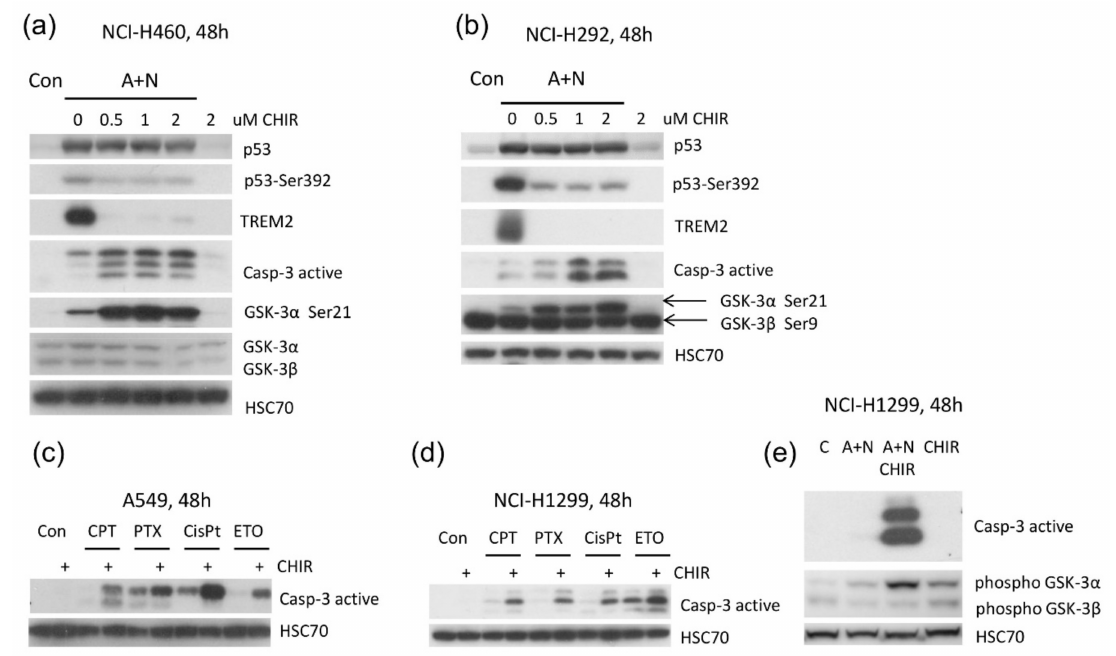
Figure 8. CHIR-98014 promotes activation of caspase-3 and represses TREM2 in cell lines other than A549. ( a , b ) Two lung cancer cell lines NCI-H460 and NCI-H292 with wild-type p53 were treated as indicated. The expression of selected proteins or their forms phosphorylated on indicated amino acids was examined by Western blotting. ( c , d ) The expression of active caspase-3 in cells exposed to anticancer drugs acting alone or in combination with CHIR-98014. The following concentrations of drugs were used: camptothecin (CPT) 1 µ M, paclitaxel (PTX)-5 µ M, cisplatin (CisPt)–20 µ M, etoposide (ETO)–20 µ M, CHIR-98014 -1 µ M. ( e ) The expression of active caspase-3 and phosphorylated forms of GSK-3 α or GSK-3 β in p53-null NCI-H1299 cells exposed as indicated. The concentration of CHIR-98014 was 2 µ